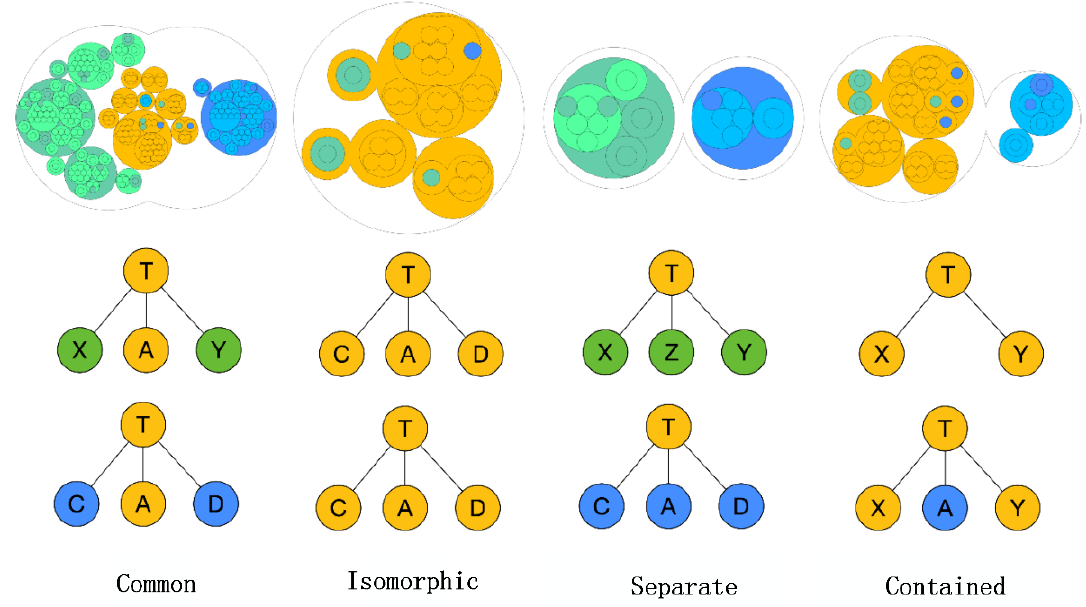
Figure 10. Basic patterns of structural differences.